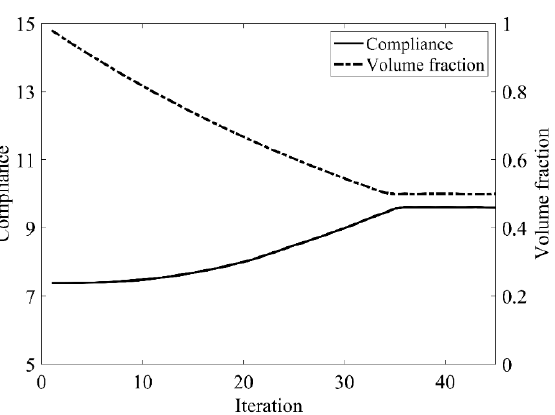
Figure 6. Convergence history of the compliance and volume fraction for two-dimensional simple bridge beam by traditional BESO.